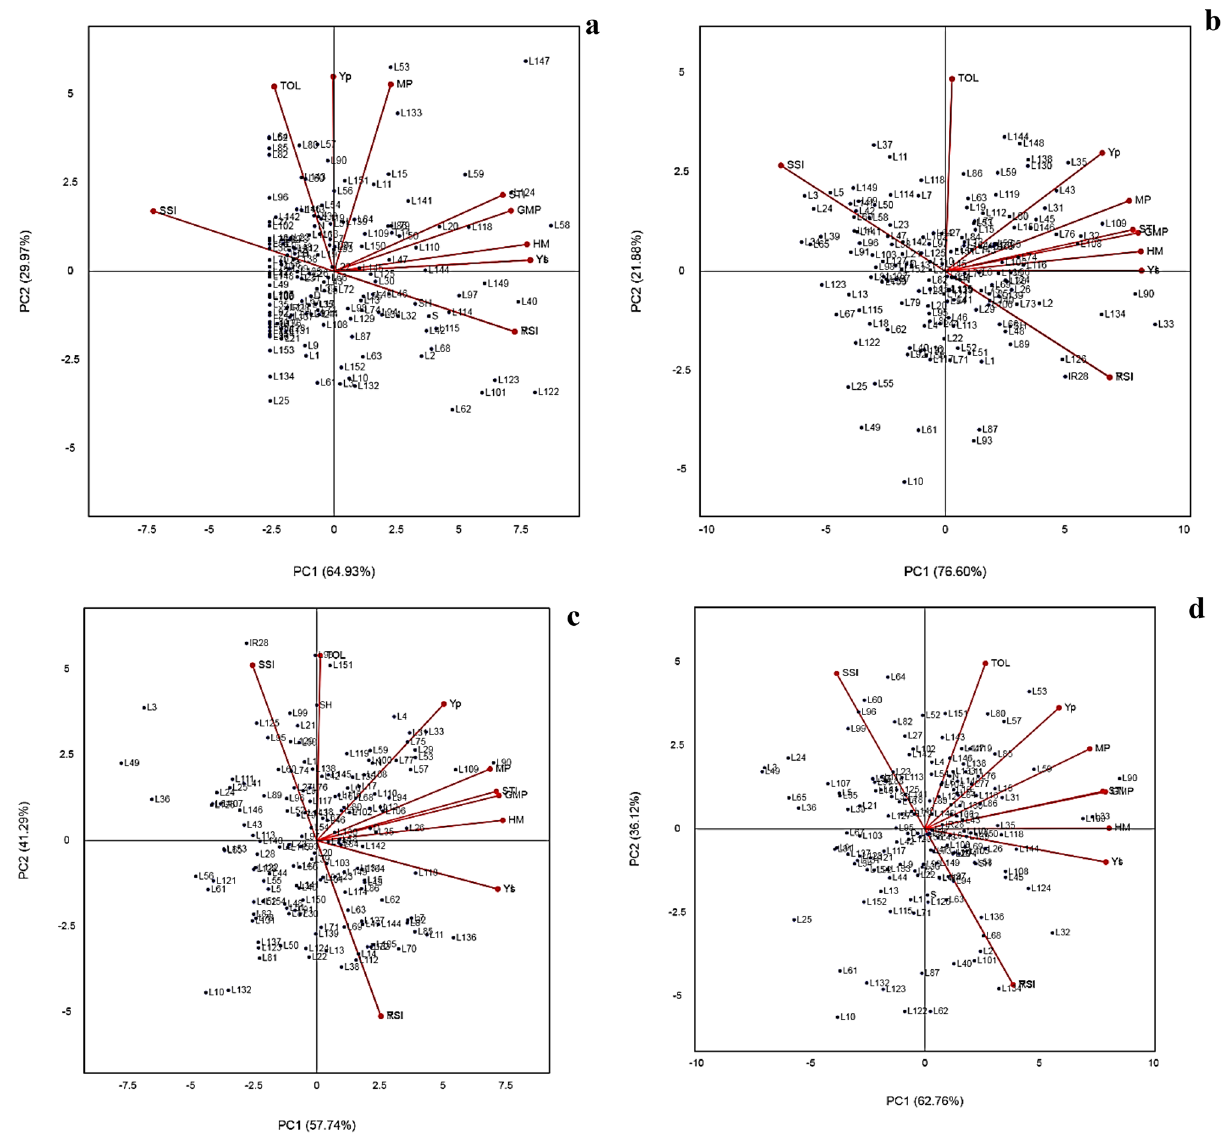
Figure 3. Graphic display biplot for drought tolerance indices based on grain yield of 152 rice RILs, parental (IR28 and SH: Shahpasand) and check varieties (N; Neda, S; Sadri, D; Dorfak) under non-stress and drought stress conditions in 2017 ( a ), 2018 ( b ), 2019 ( c ), and average of all 3 years from 2017 to 2019 ( d Identification of promising lines for drought stress based on polygon view of the GT‑biplot. A polygon view of the rice RILs GT-biplot with symmetrical scaling considering all the 3 years is presented in Fig. 5. This polygon is drawn by joining the genotypes located away from the biplot origin so that all the other genotypes are contained in the polygon. Perpendicular lines were drawn to each side of the polygon, which divided the biplot into the sectors. The vertex line in each sector exhibits the most efficient line in the environ- ment that falls in that specific sector. Lines L147, L118, L58, and L53 are the best performers in the sector of 2017 indices, and lines L90, L109, L33, L136, and L35 for the sectors of 2018 and 2019 indices. In contrast, lines L10, L25, L49, L24, and L122 were in the vertex of the polygon, yet not in the vicinity of any of the indices and yield, suggesting that these lines were of the lowest values for the yield and indices. Based on ANOVA in both conditions non-stress and drought stress, genotype × year interaction effect was estimated significant. Therefore, it is important to consider the interactions of genotype in the environment and performance of rice lines in these 3 years with different environments. In order to identify the lines that were less affected by the environment and had more stability in the 3 years, we used GGE-biplot with the which-won- where pattern of lines and years. Figure 6 shows a polygon view of the GGE biplot symmetrical scaling rice RILs representing the superior lines in each of the six environments. According to the biplot, the sector of 2017N (non-stress condition in 2017), 2017D (drought stress condition in 2017), and 2019D, lines L85, L64, L147, L53, L80, L57, L90, L11, and L59 produced the highest grain yield. Similarly, in 2018D, 2018N, and 2019N sectors,